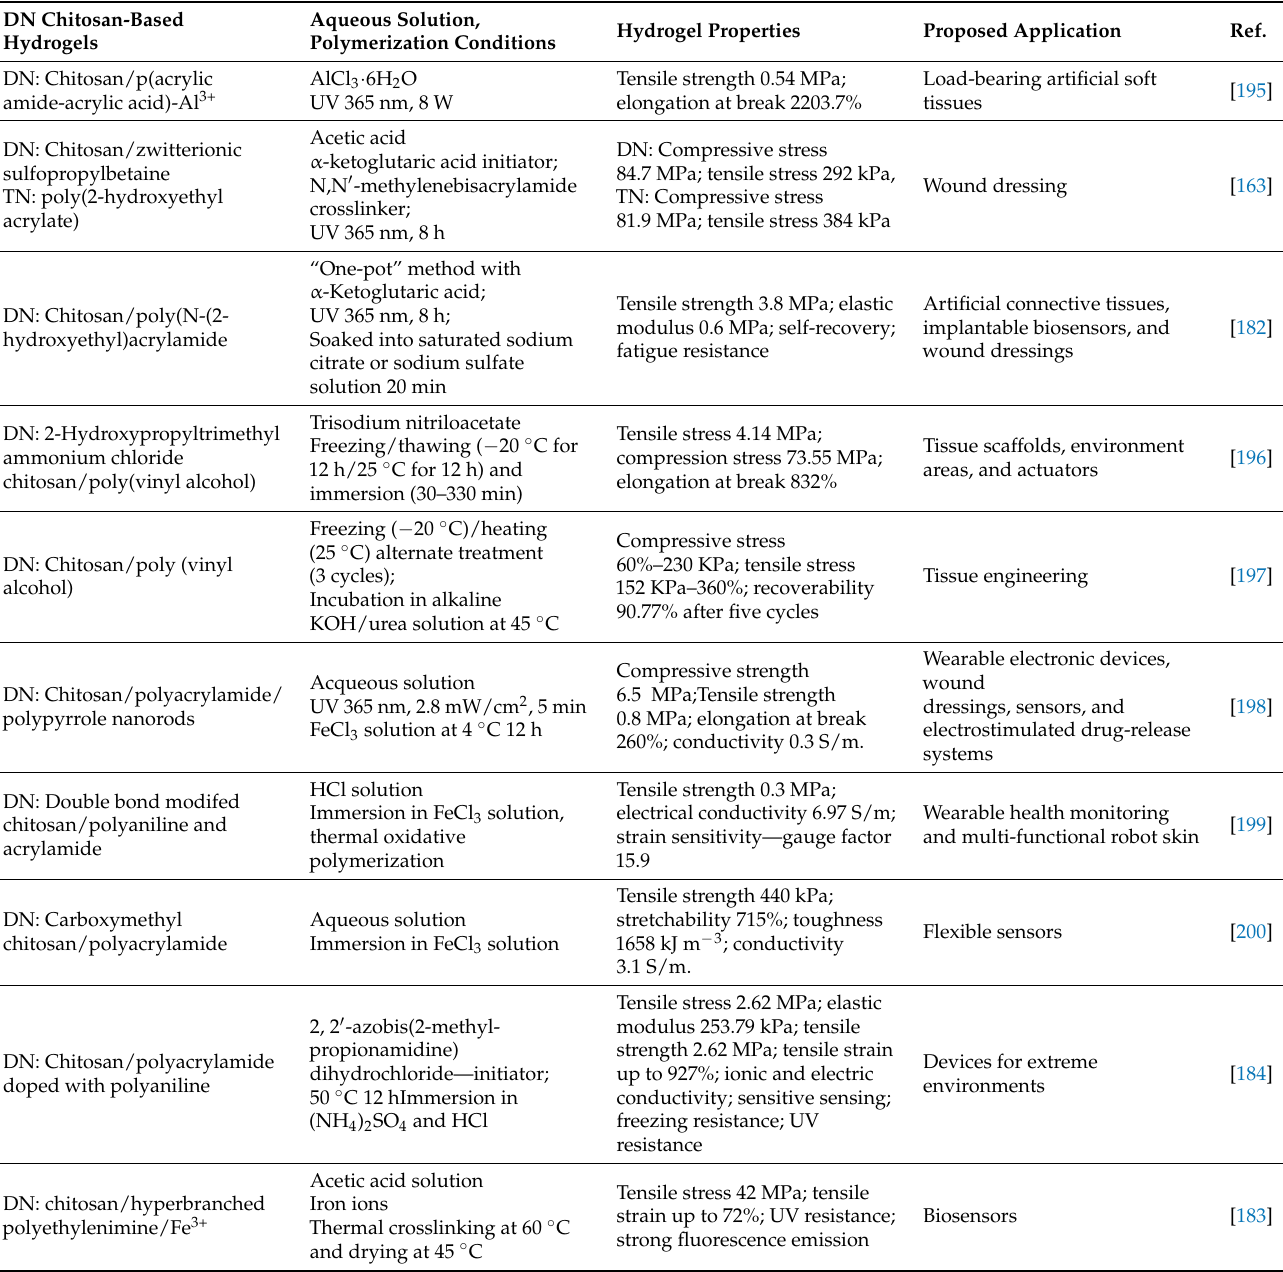
Table 1. DN chitosan-based hydrogels with improved mechanical and physical properties and their proposed